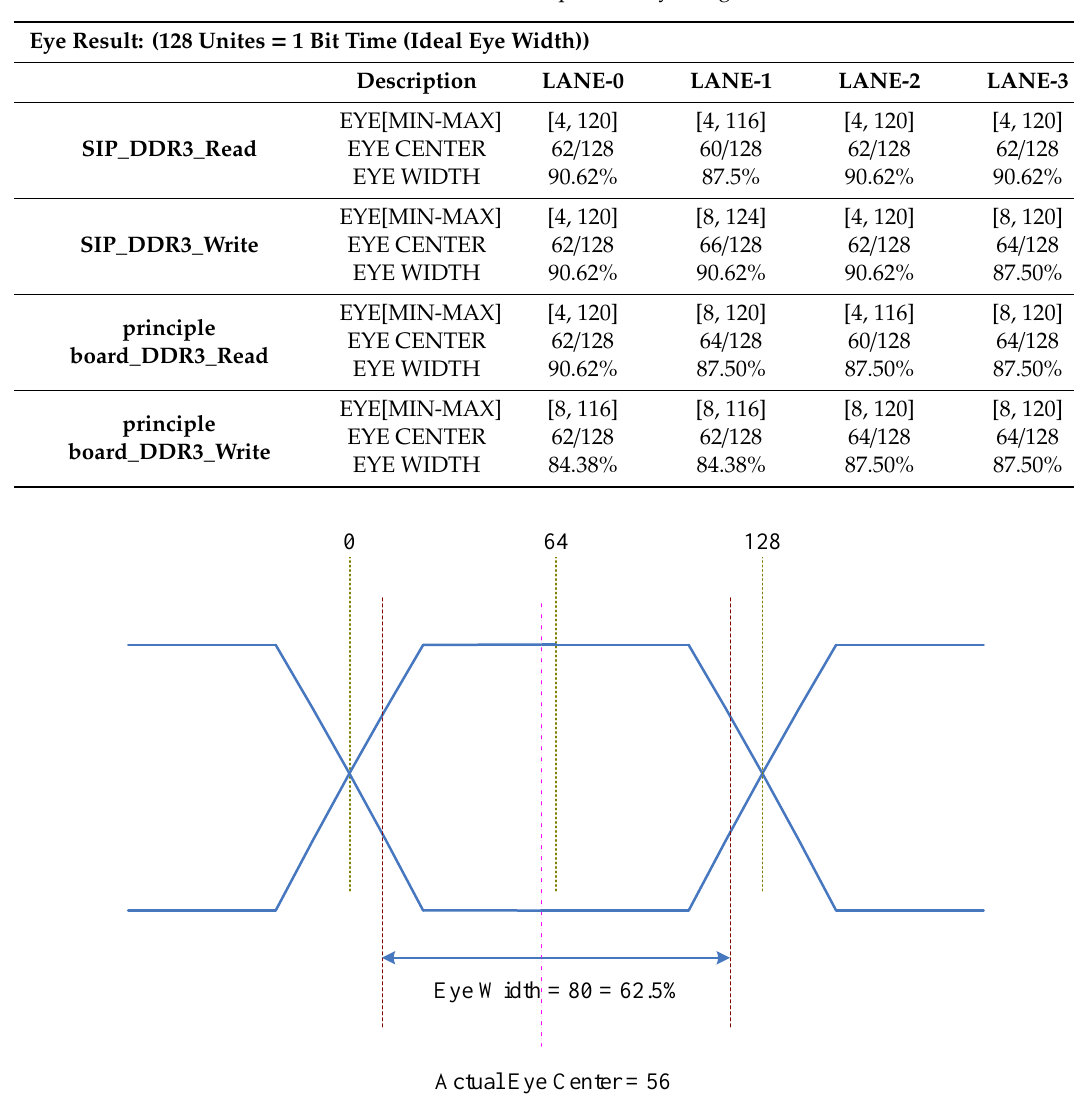
Table 4. DDR3_DQS read / write operation eye diagram test results.